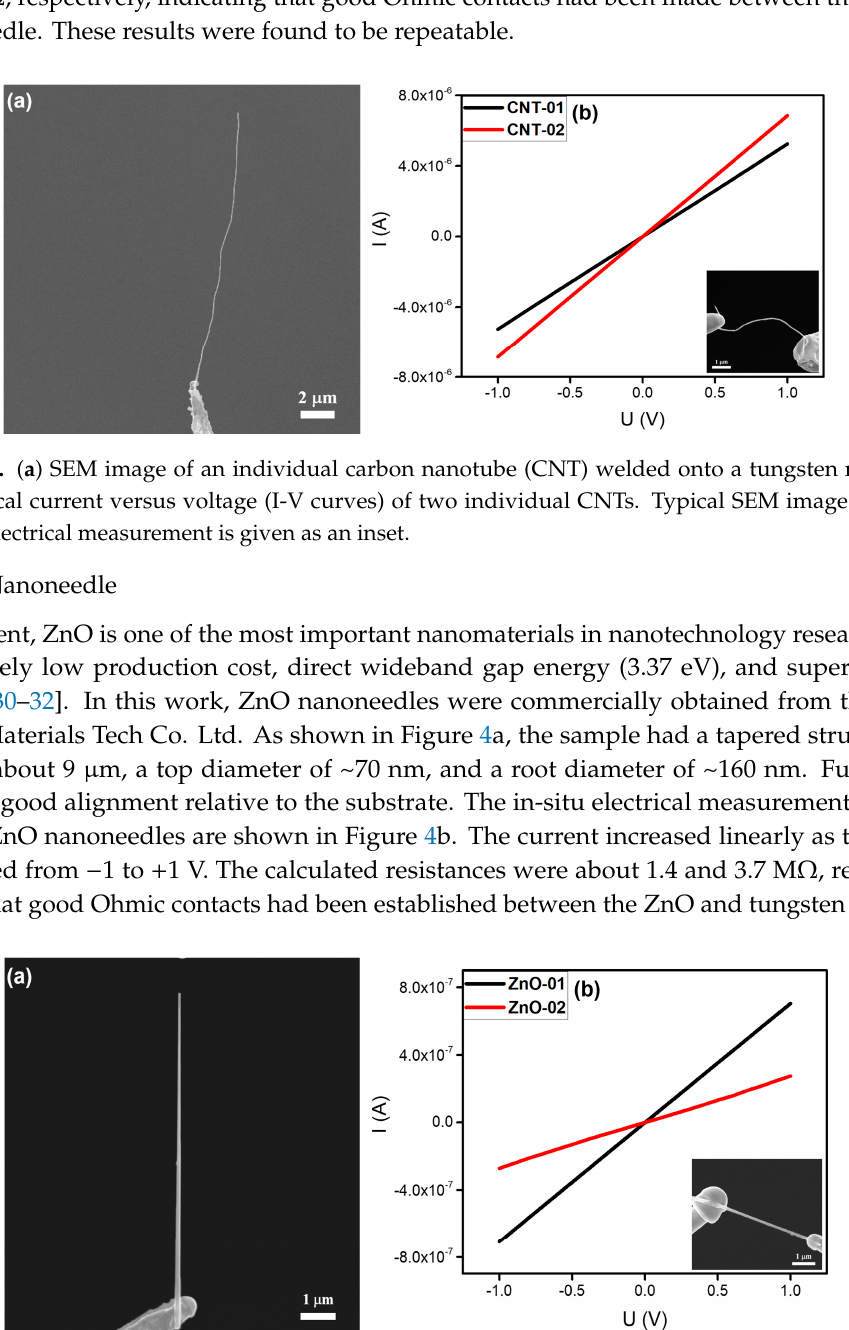
Figure 4. ( a ) SEM image of an individual ZnO nanoneedle welded onto a tungsten needle. ( b ) Typical current versus voltage (I-V curves) of two individual ZnO nanoneedles. Typical SEM image of the in-situ electrical measurement is given as an